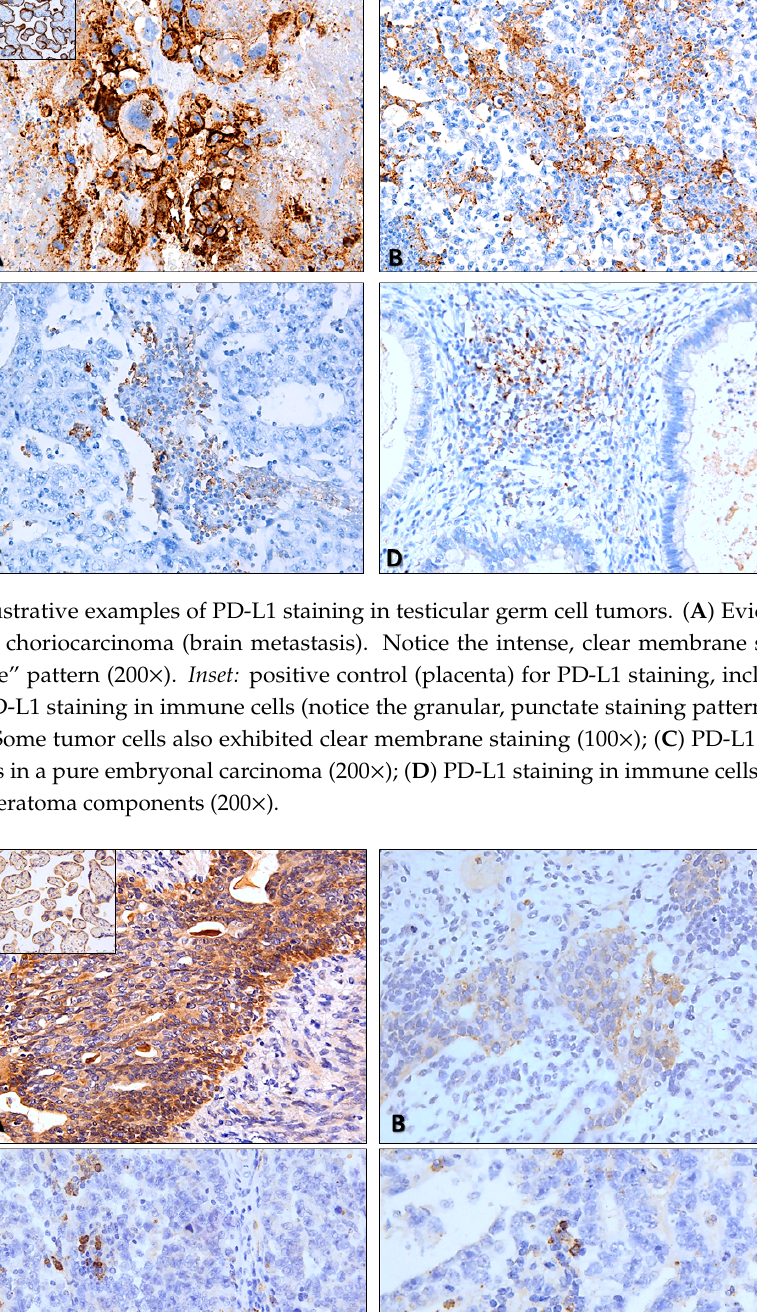
Figure 3. Immunoexpression of CTLA-4 and PD-L1 in immune cells of testicular germ cell tumors. CTLA-4 positivity ( A ) and expression above the 50% cutoff ( C ) in immune cells among seminomas and non-seminomas. PD-L1 positivity ( B ) and expression above the 50% cutoff ( D ) in immune cells